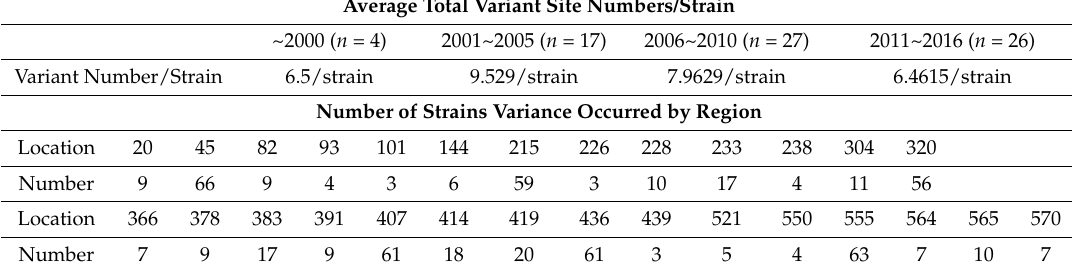
Table 5. Nucleotide substitutions occurred in 28 highly variant regions of the VP2 gene of 74 strains compared to strain NADL-2 (accession number: NC_001718.1). The average total variant site number/strain was estimated according to four groups classified into five years. The variance in every region was measured and the eight most variable regions were checked.